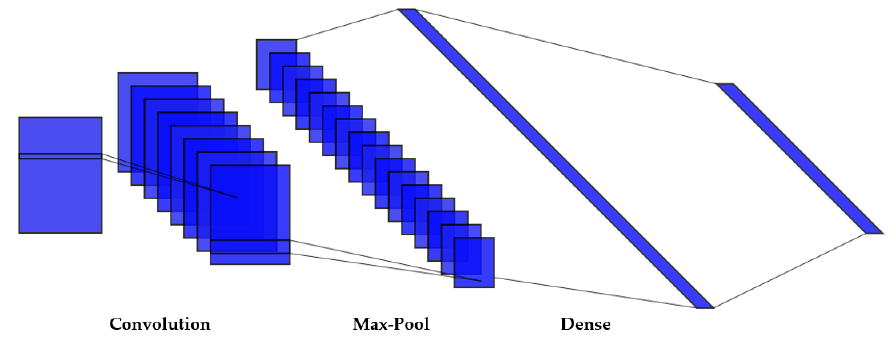
Figure 3. The structure of 1DCNN.